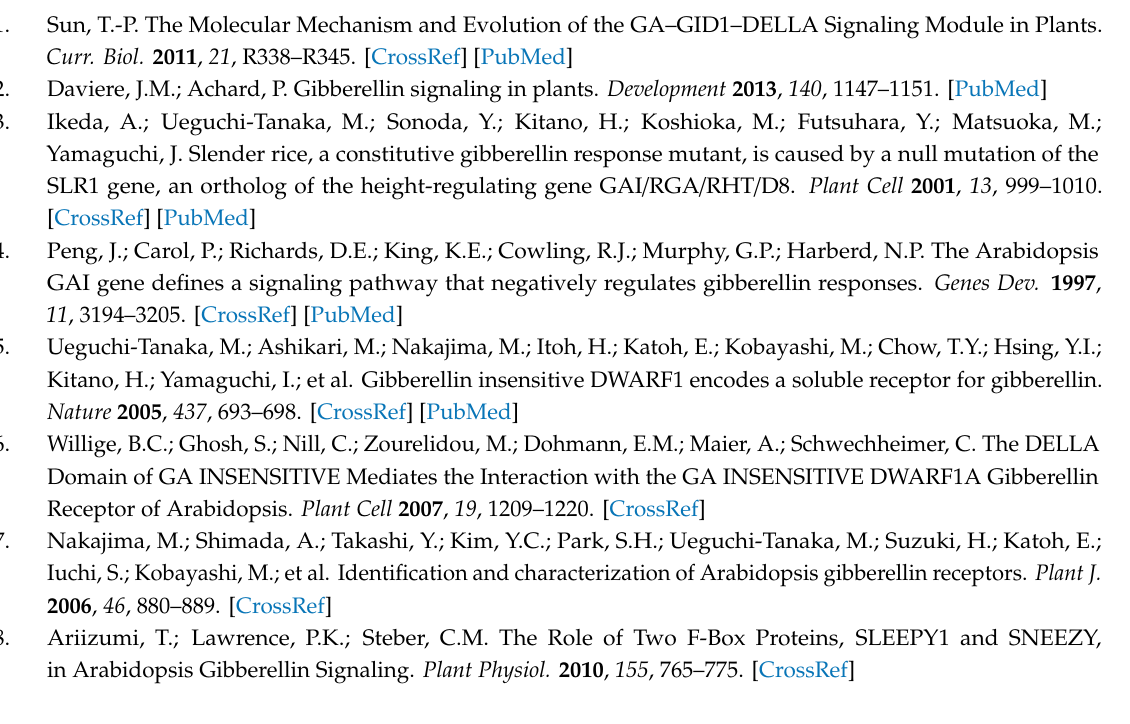
Figure S1: Morphological phenotypes of tobacco overexpressing LhSLRL , Figure S2: Morphological phenotypes of Arabidopsis overexpressing LhRGA , Figure S3: Sampling method, Figure S4: PCR testing for Arabidopsis overexpressing LhSLRL , Figure S5: PCR testing for Arabidopsis overexpressing LhRGA , Figure S6: RT-PCR analysis of wild types and Arabidopsis / tobacco overexpressing LhDELLA s, Figure S7: PCR testing for tobacco overexpressing LhSLRL , Figure S8: The thermal profile of qRT-PCR, Table S1: DELLA proteins of di ff erent species, Table S2: Primers used for gene cloning, Table S3: Primers used for qRT-PCR, RT-PCR, and PCR testing, Table S4: Identity matrix for LhSLRL / LhRGA and five DELLA proteins in Arabidopsis